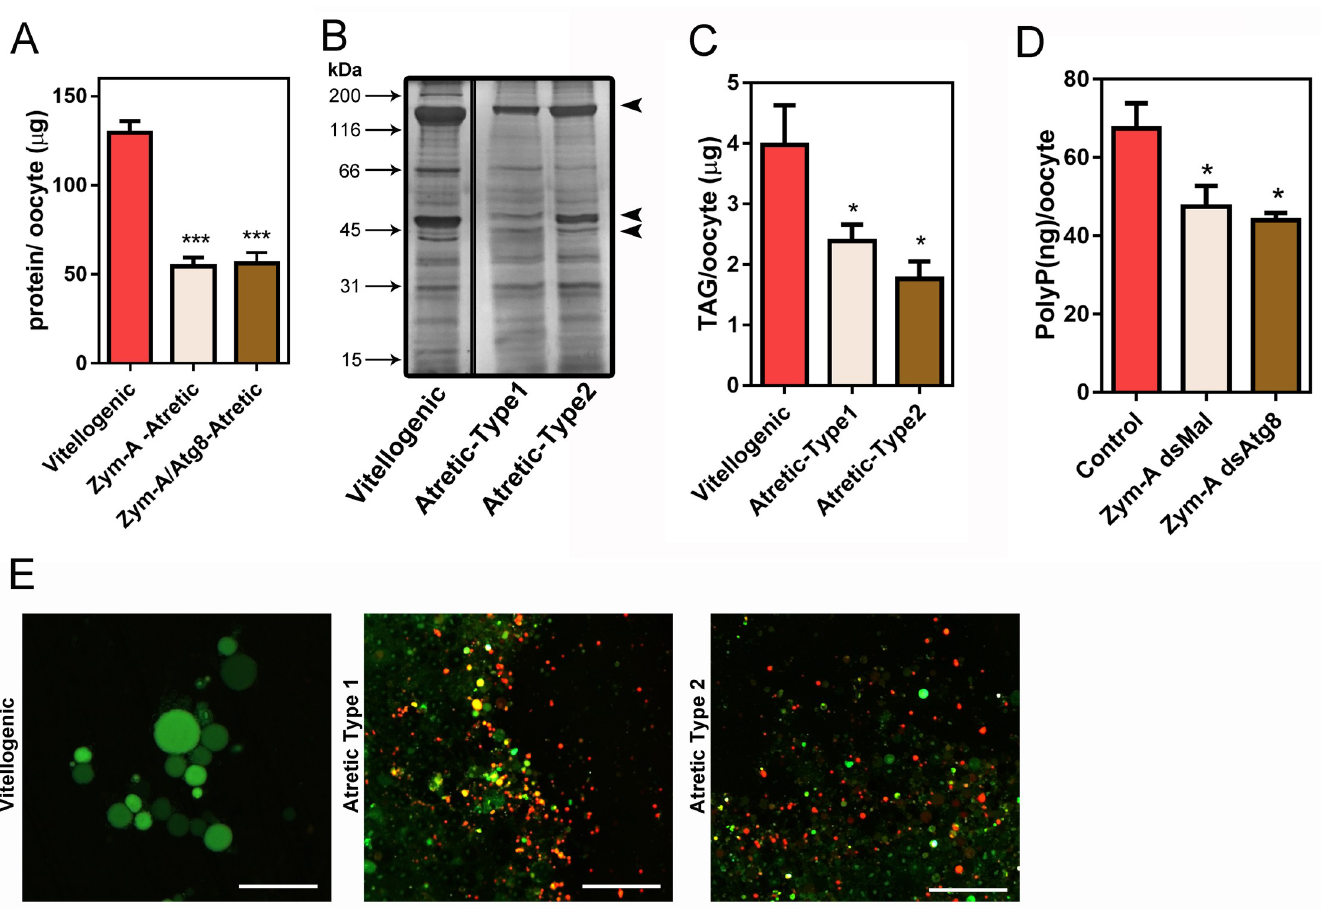
Fig 4. Silencing of RpATG8 does not affect degradation of the main yolk macromolecules during follicular atresia. A. Total protein quantifications in vitellogenic, control atretic (Type1) and silenced atretic (Type2) oocytes (n = 7). B. 10% SDS-PAGE showing the protein profile of vitellogenic and both types of atretic oocytes (n = 3). Arrows indicate vitellogenin subunits. C. TAG content detected in vitellogenic and both types of atretic oocytes (n = 6). D. PolyP content detected in vitellogenic and both types of atretic oocytes (n = 4). E. The yolk organelles from each of the oocytes (vitellogenic, atretic type-1 and atretic type-2) were incubated with 5 μ g/ml Acridine Orange (AO) and observed under the fluorescence microscope (n = 5). Bars: 50 μ m. � p < 0.05, ��� p < 0.001, One Way